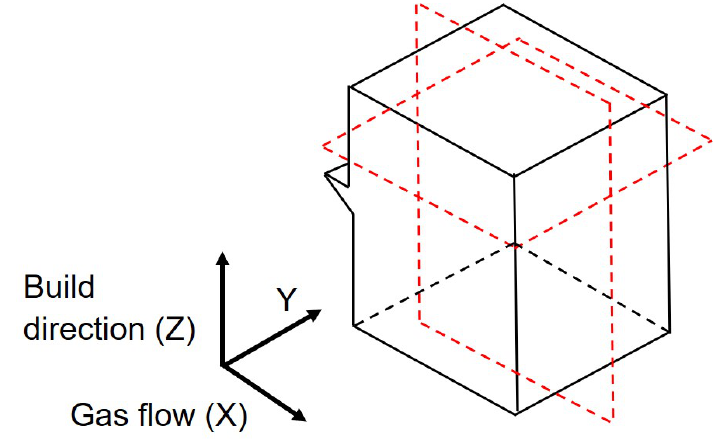
Figure 2. Cube design showing the build direction and gas flow direction. The red dotted lines indicate the cutting planes used for sample